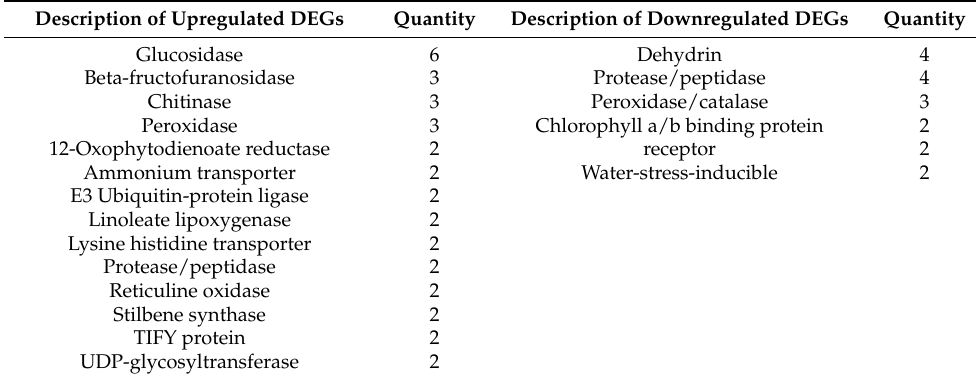
Table 10. Comparison of most frequent simplified DEG descriptions between the up- and down- regulated parts of the overlapping inoculation and wounding induced response (total number of upregulated DEGs = 87, downregulated DEGs =